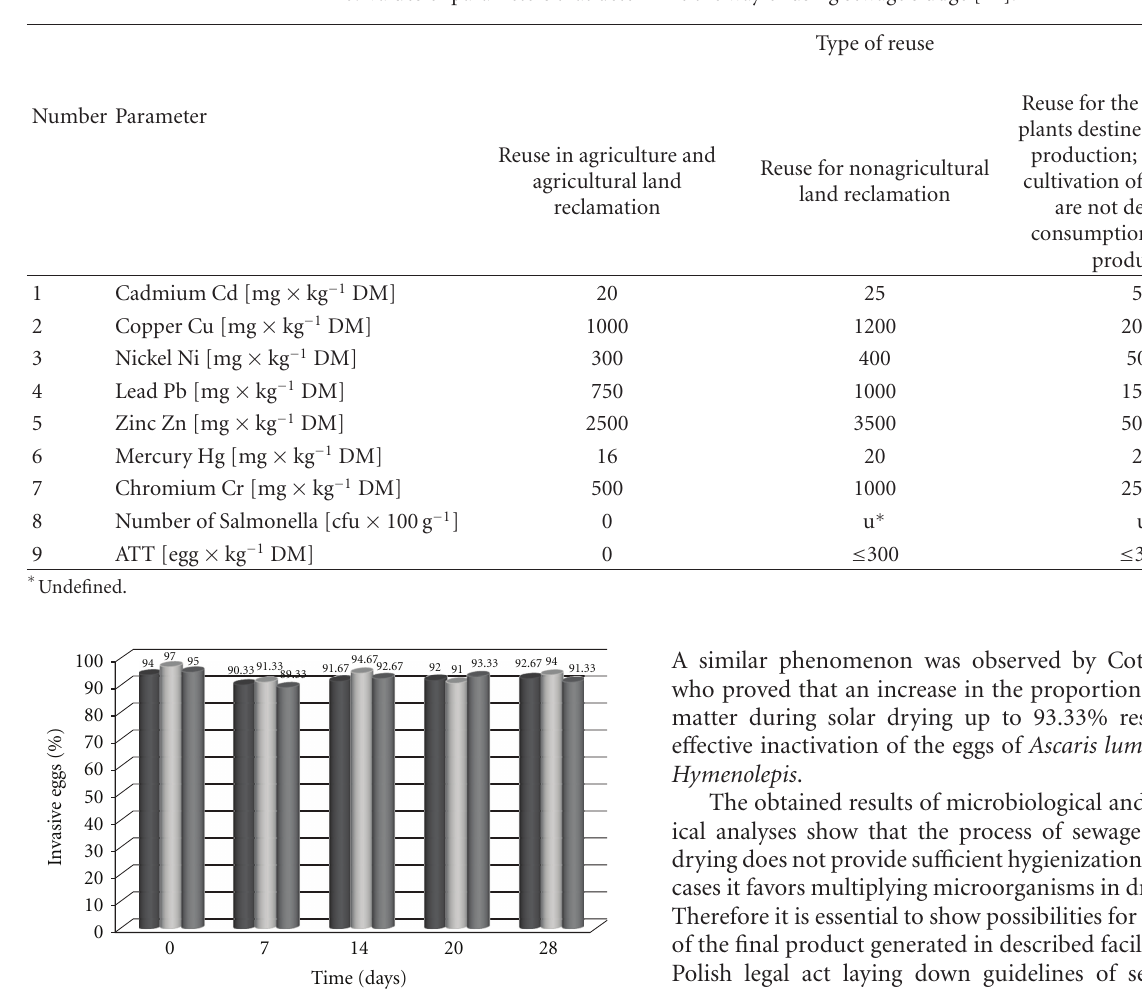
Table 6: Values of parameters that determine the way of using sewage sludge [11].